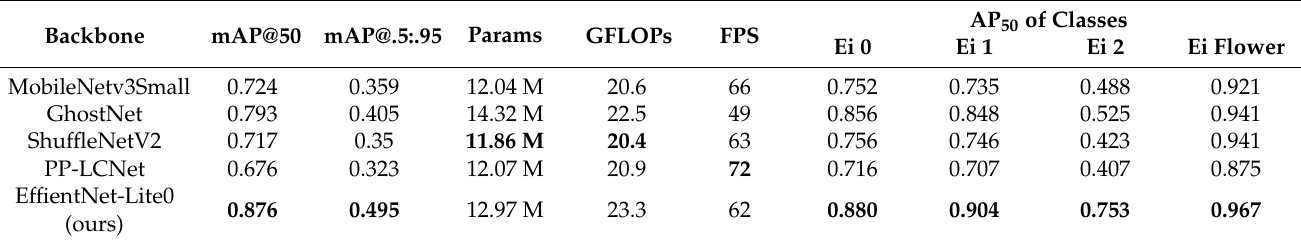
Table 3. Comparison of various feature extraction